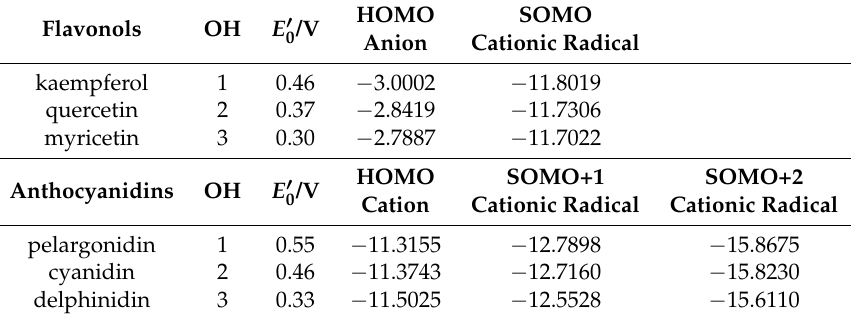
Table 2. Table of extent of substitution in B ring, oxidation potentials E (cid:48) energies in electron-volts (eV) for flavonols and